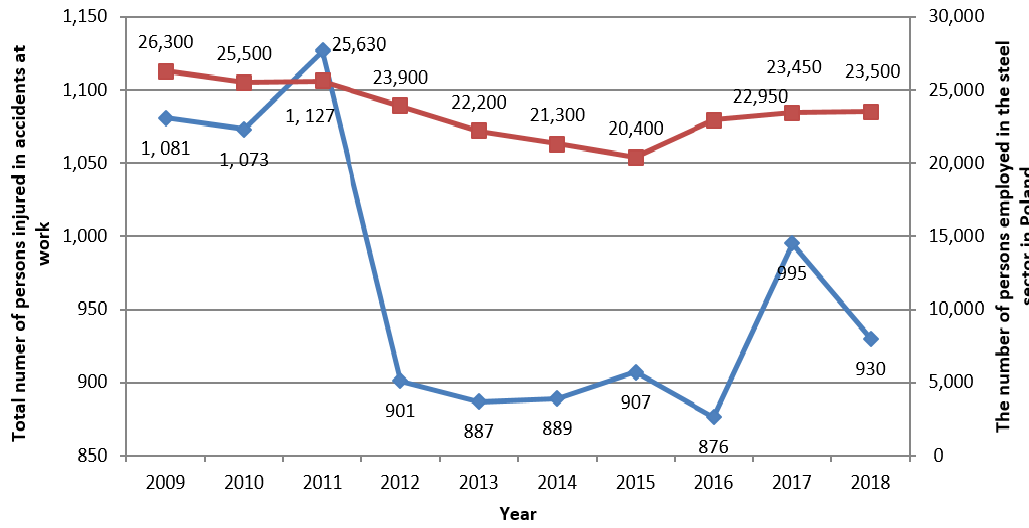
Figure 2. Persons injured and employed in the steel industry in Poland in 2009–2018 [66,67]. Table 2. Key information about Polish steel production (own study based on [66,67]).